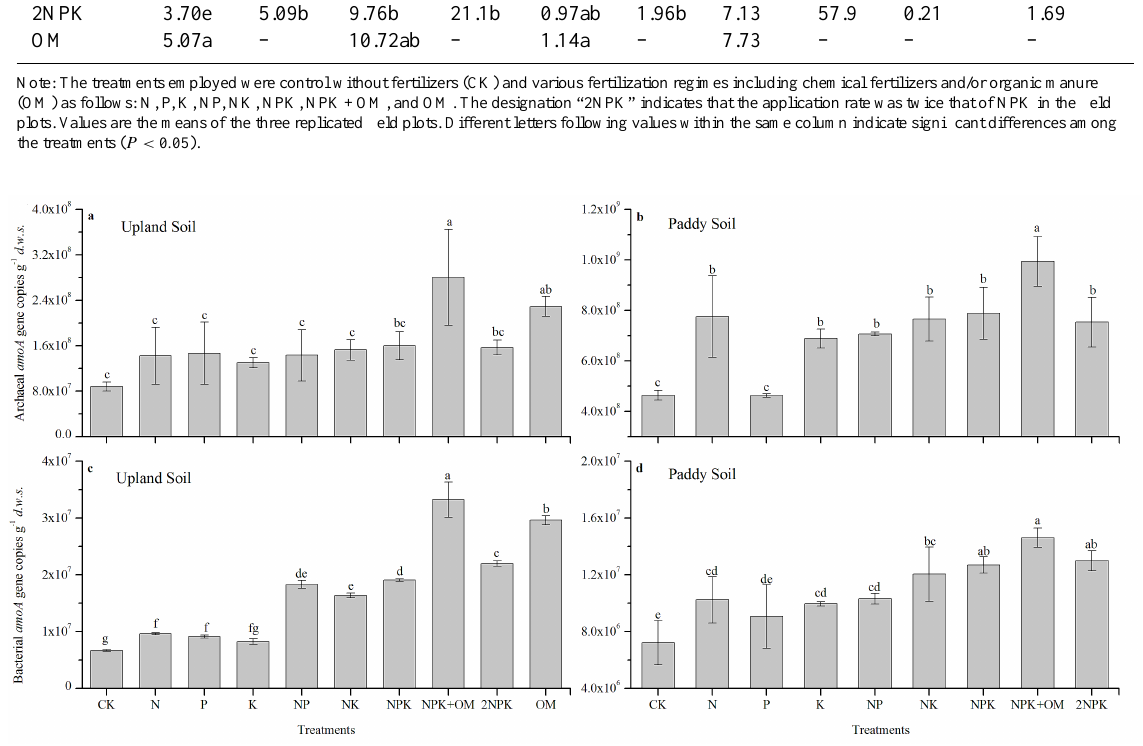
Fig. 1. The amoA gene abundance of Archaea (a, b) and of Bacteria (c, d) in upland and paddy soils. The treatments were control without fertilizers (CK) and various fertilization regimes including chemical fertilizers and/or organic manure (OM) as follows: N, P, K, NP, NK, NPK, NPK+OM, and OM. The designation “2NPK” indicates that the application rate was twice that of NPK in the field plots. Error bars represent the standard deviation of the three field replicate field plots examined for each treatment. The same letter above the columns indicates no statistically significant difference among the treatments ( P > 0 .